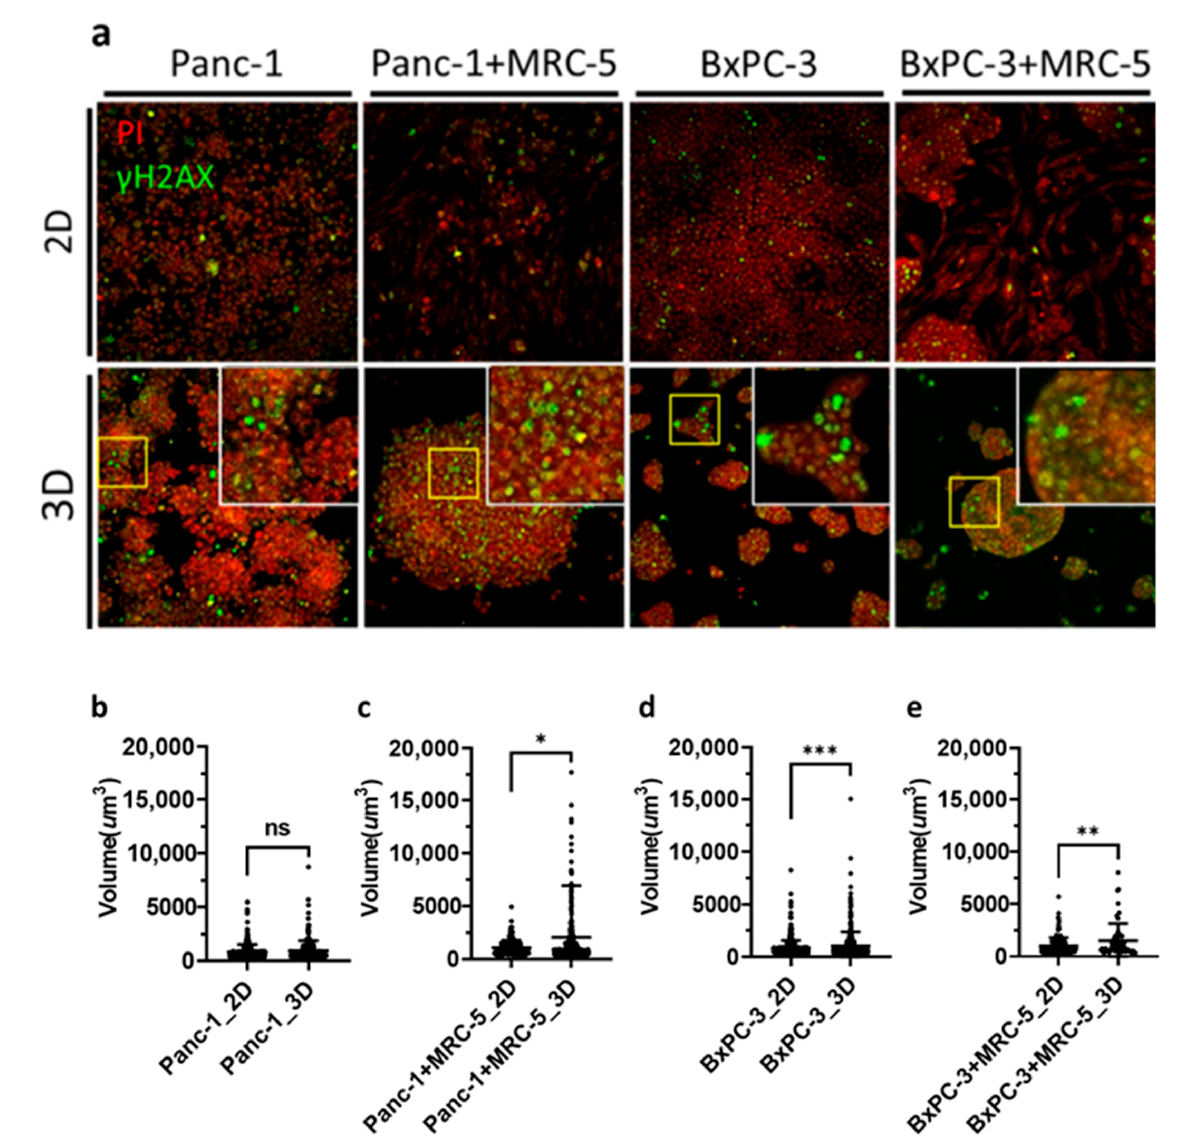
Figure 5. Immunofluorescence staining against phosphorylated histone H2AX ( γ H2AX) for BNCT-induced double strand break in pancreatic cancer cells. ( a ) Panc-1 and BxPC-3 cells treated with BPA before BNCT irradiation. Cells were fixed after irradiation and stained with γ H2AX and propidium iodide. Images were obtained through confocal microscopy (20 × Magnification). ( b – e ) Density dot plots of the volume of γ H2AX foci; the mean values for 2D and 3D samples were ( b ) 865.3 and 971.9, (c) 1057 and 2053, ( d ) 857.8 and 1079, and ( e ) 1032 and 1515, respectively. ns, non-significant; * p < 0.05, ** p < 0.01, *** p < 0.001.